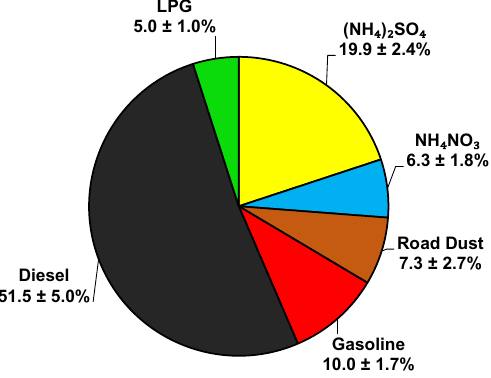
Figure 5. Average PMF-derived source contributions to PM 2.5 in the tunnel.